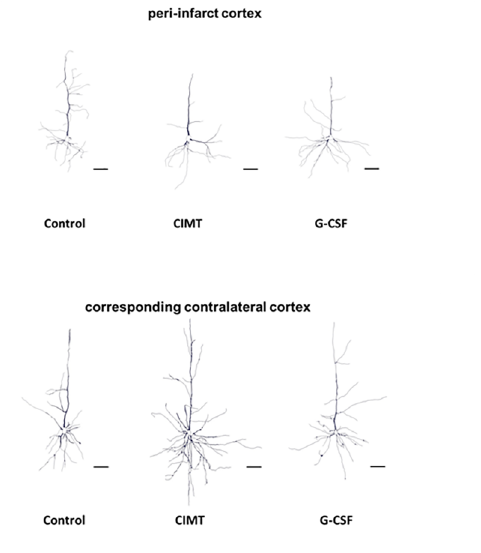
Fig 4. Representative pictures of Golgi Cox-impregnated layer V pyramidal neurons of the control, CIMT and G-CSF-treated group in the peri-infarct cortex (A) and the corresponding contralateral cortex (B), respectively. Note the increase of the basilar dendritic arbor in the peri-infarct cortex of G-CSF treated rats. Scale bar: 50 μ m.